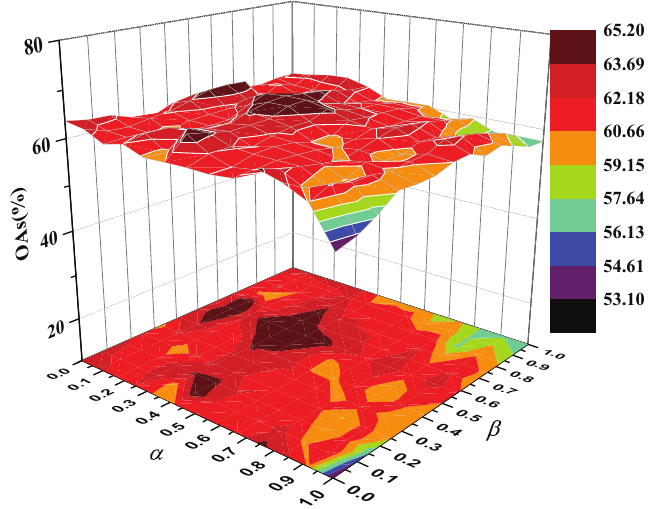
Figure 7. The OAs of SSRHE with different α and β on PaviaU dataset.